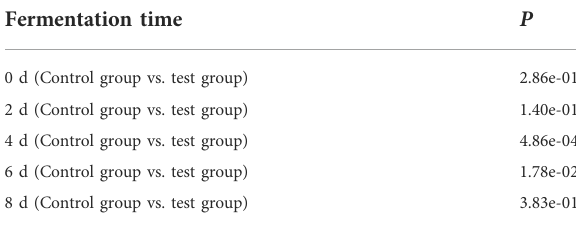
TABLE 3 T -test results of total major amino